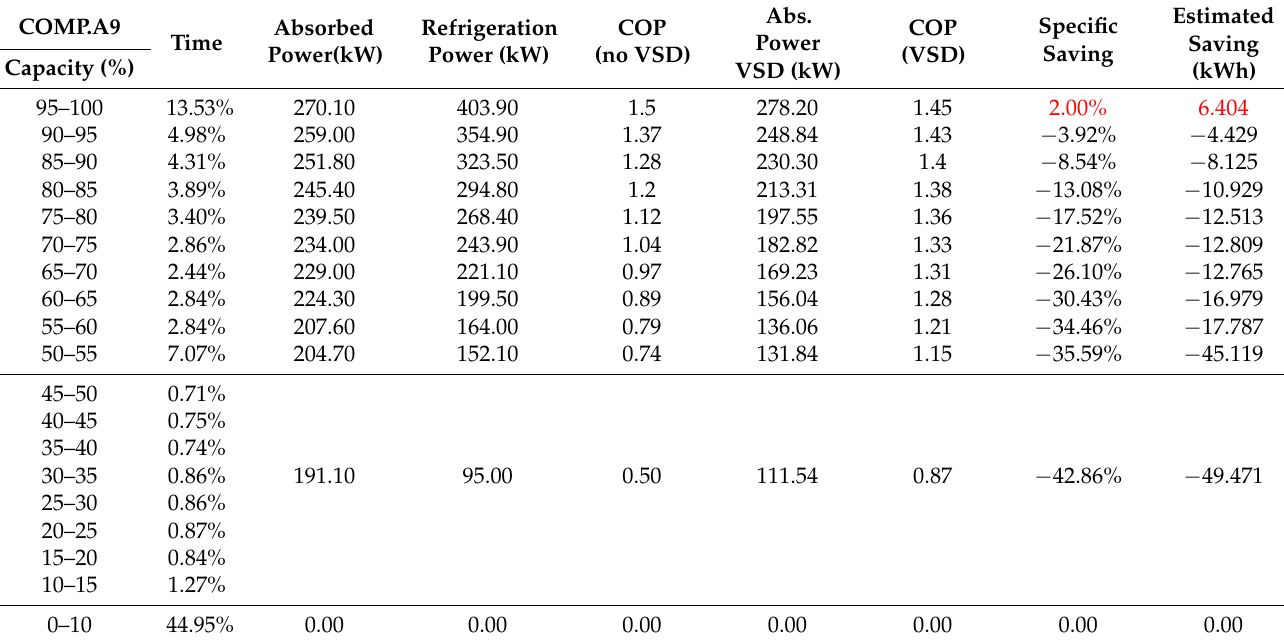
Table 4. Energy saving results due to speed variation in compressor N ◦ .